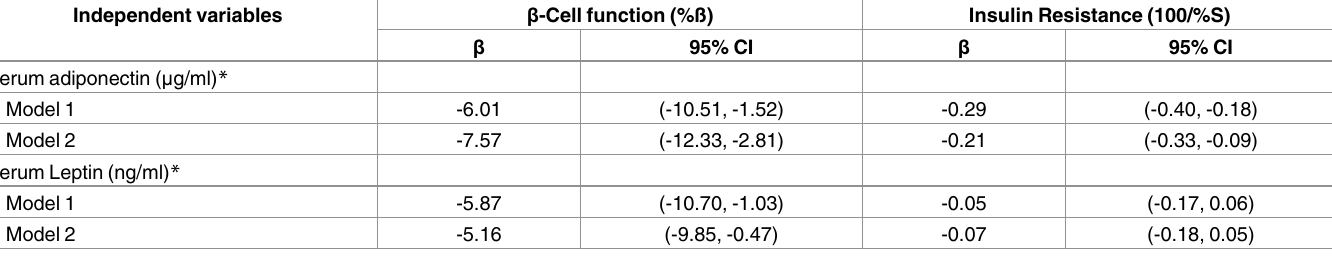
Table 3. Multiple linear regression analysis of the associations between serum adipocytokines and HOMA parameters among 783 rural Chinese residents in Ningxia, 2008–2012. Independent variables